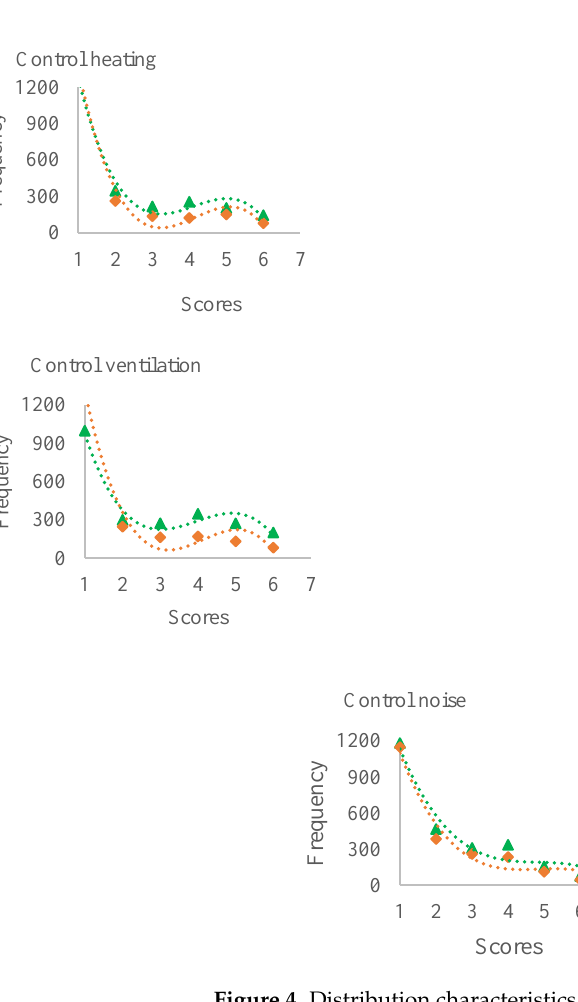
Table 8. Comparison of mean values of overall comfort and productivity scores between green and non-certified buildings.